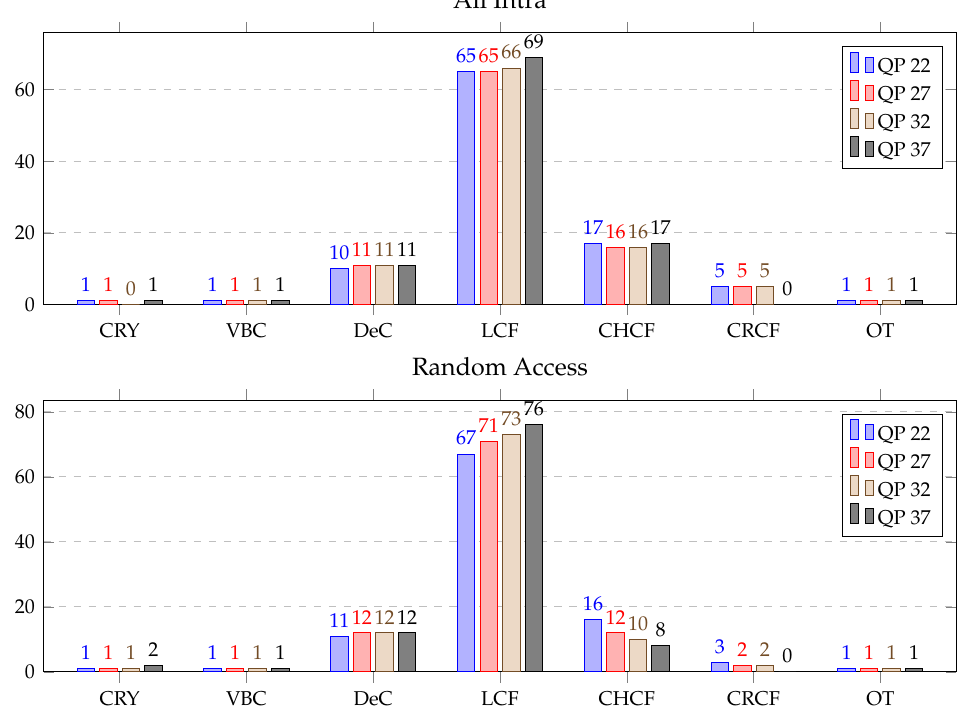
Figure 12. Average time distribution for different parts of the adaptive loop filter (in %) over the EGPP. Table 7. Average processing times (in %) for the ALF block profiled over the HGPP and EGPP.